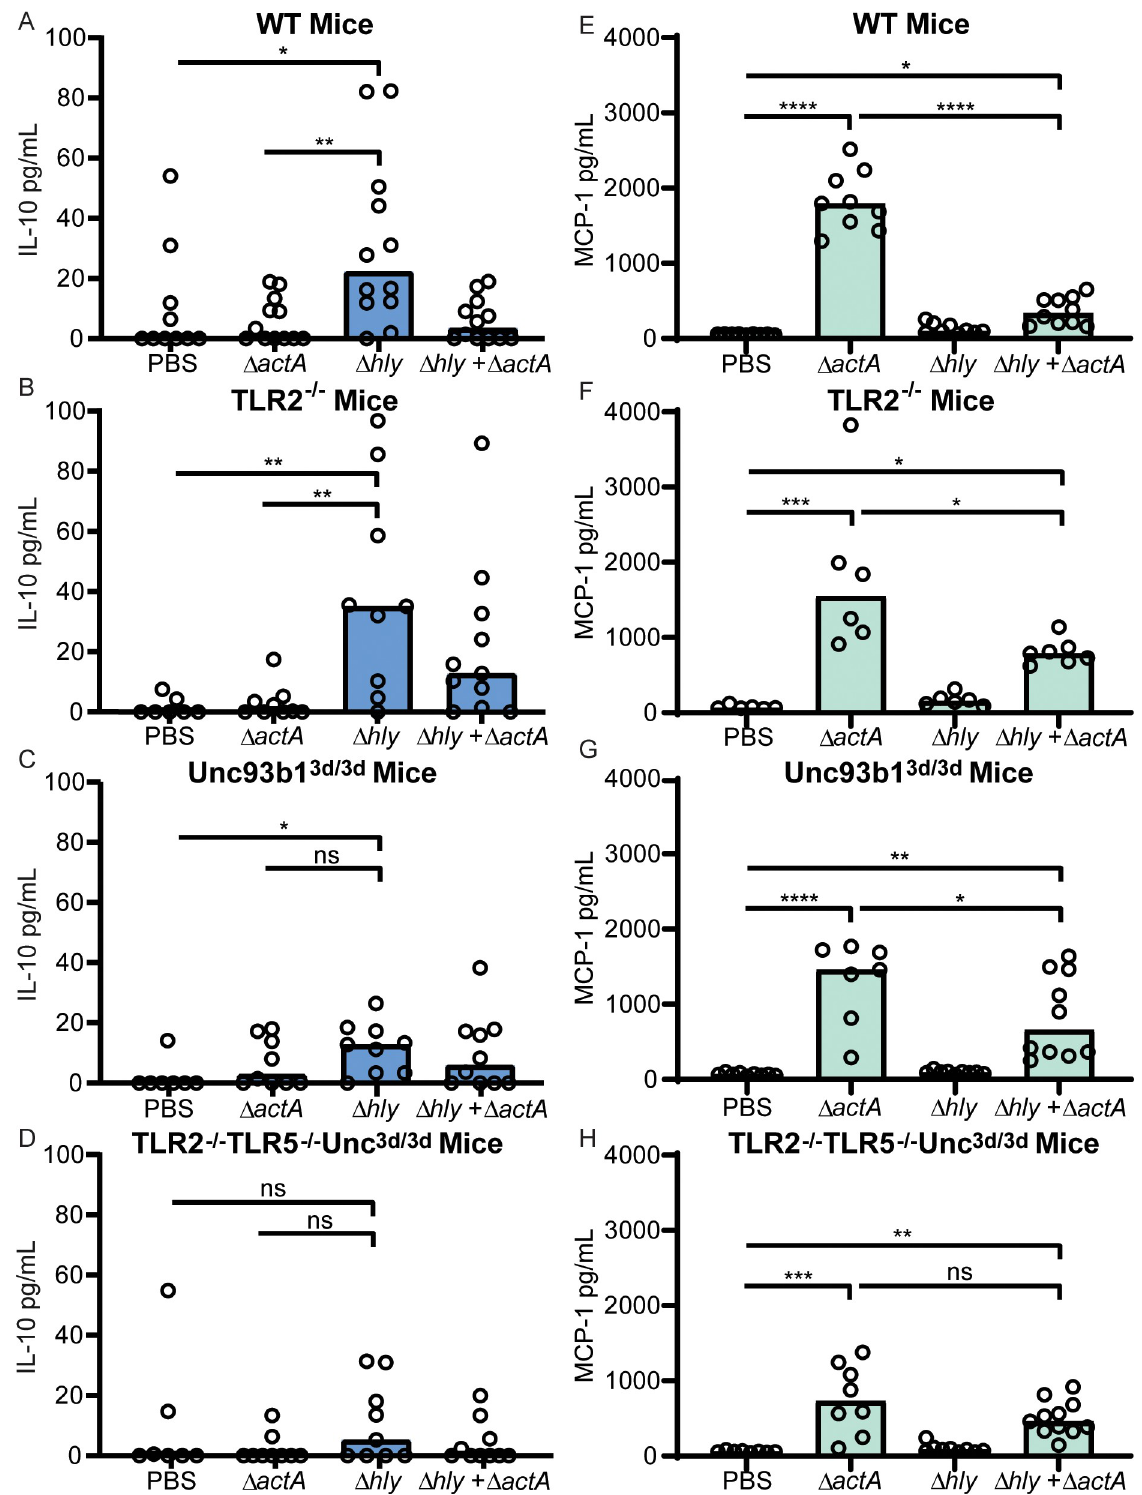
Fig 4. L . monocytogenes induces IL-10 and MCP-1 secretion in mice. Mice were infected with 10 8 CFU of Δ hly , 10 5 CFU of Δ actA , or a combination of 10 8 CFU of Δ hly and 10 5 CFU of Δ actA . WT C57BL/6J mice (A and E), TLR2 -/- (B and F), Unc93b1 3d/3d (C and G), and TLR2 -/- TLR5 -/- Unc93b1 3d/3d (D and H) were infected. Serum measurements of IL-10 four hours post-infection (A-D) and MCP-1 twenty-